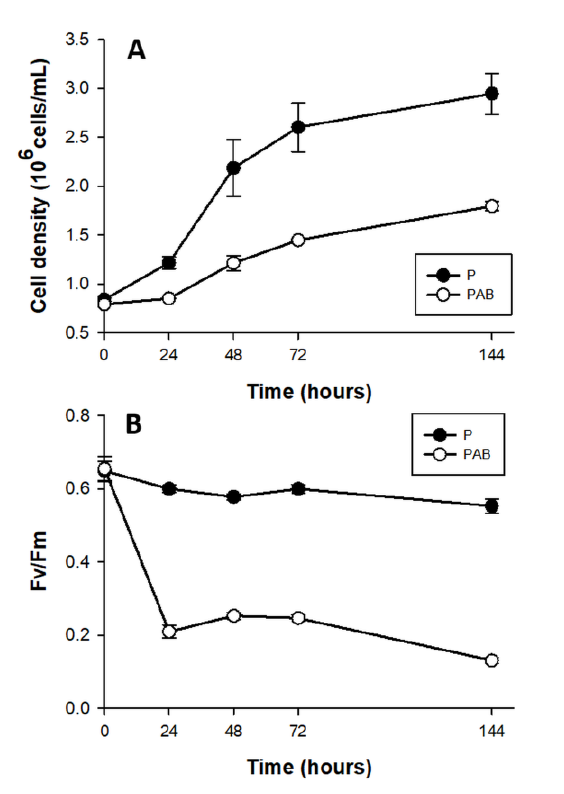
FIGURE 1. Cell abundance (A) and maximal quantum yield (F v /F m ) (B) in cultures of D. tertiolecta exposed to PAR (P, ●) and to PAR + UVA + UVB (PAB, ○) for six days immediately after the day 0 measurement (culture in P). Symbols are means of meas- urements of two independent replicate cultures and three repli- cate samples from each culture cylinder. Error bars indicate standard deviations. Figure reproduced with permission of The Journal of Experimental Botany